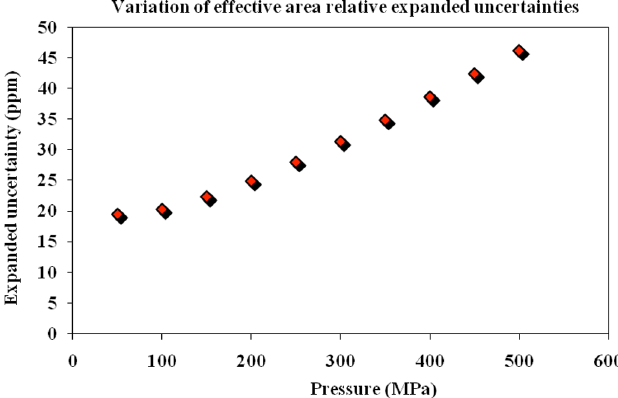
Fig. 7. Relative expanded uncertainty of the obtained effective area as a function of pressure.